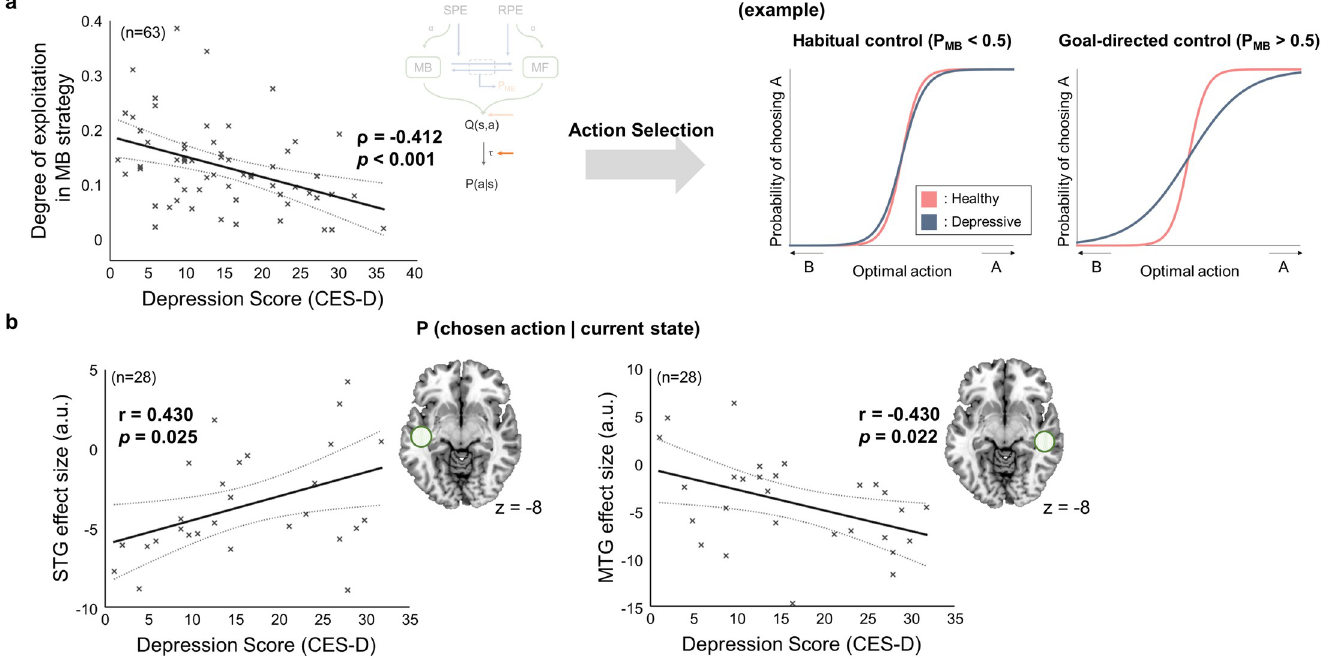
Fig 8. Parametric effect of subclinical depression on value-action conversion. (a) Effects of subclinical depression on model parameters (n = 63; the total number of subjects, including 35 who participated behavioral experiment only and 28 who were also scanned with the fMRI). (Left) Relationship between the depression score and the degree of exploitation in model-based (MB) strategy ( τ MB ). The MB exploitation parameter decreases as the depression score increases. (Right) Examples illustrating exploitation parameter effects on action selection. Shown are the softmax functions that convert an action value into a choice probability value, between the healthy and the subclinical depression group for goal-directed and habitual control. Compared to the healthy group (pink), the subclinical depression group makes more exploratory choices especially as they rely more on the model-based system (blue). (b) Relationship between the depression score and the parameter estimate of the probability of selecting chosen action for the two seed regions, left Superior Temporal Gyrus (STG) ([–46,–20,–8]; z-score = 4.21) and the right Middle Temporal Gyrus (MTG) ([56,–32,–8]; z-score = 3.55). The effect size of left STG and right MTG increases and decreases with the individual severity of depressive symptom,